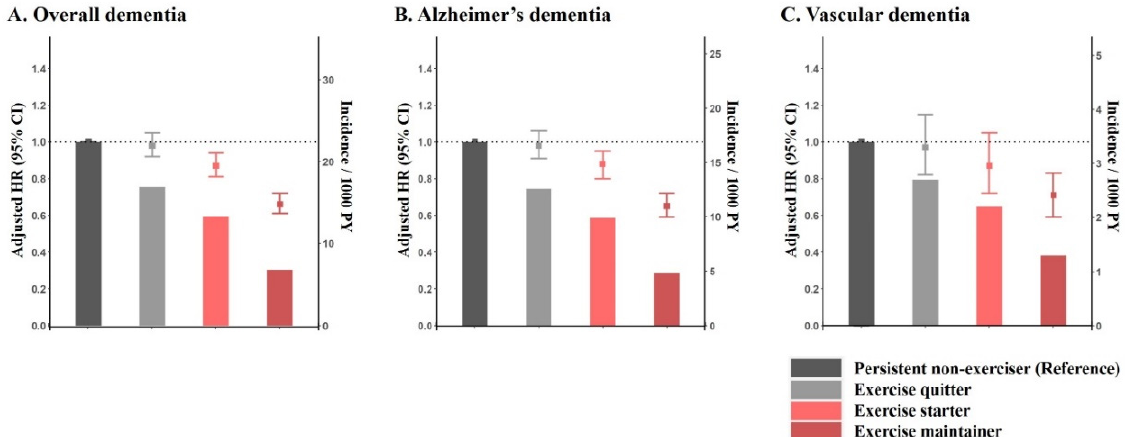
Figure 2. The association between change of physical activity and incident dementia in patients with newly diagnosed atrial fibrillation. Incidence/1000 person-years and adjusted hazard ratio for overall dementia ( A ), Alzheimer’s dementia ( B ), and vascular dementia ( C ) are presented in bars and error-bars, respectively.